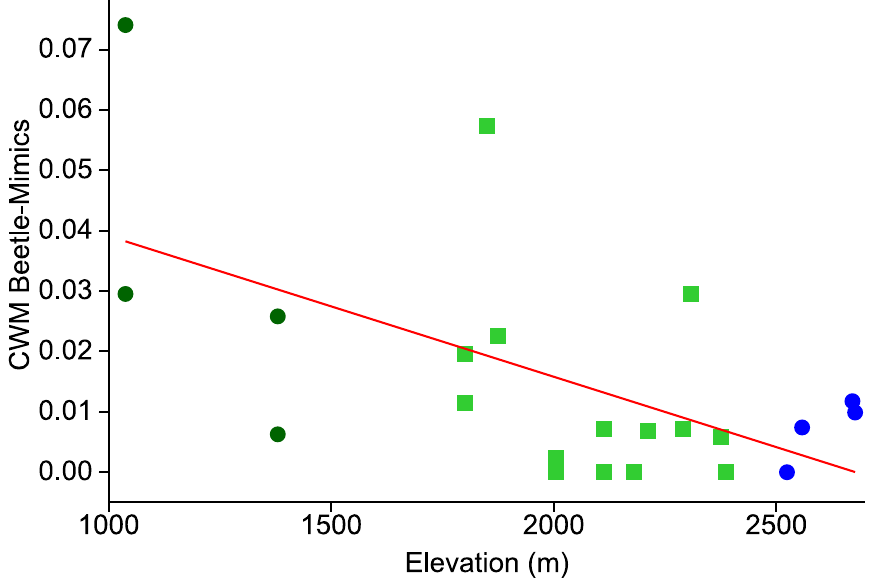
Figure 4. CWMs of beetle mimicry among 22 local Arctiinae assemblages in an elevational gradient in the Andes of southern Ecuador. See Figure 2 for further explanations.